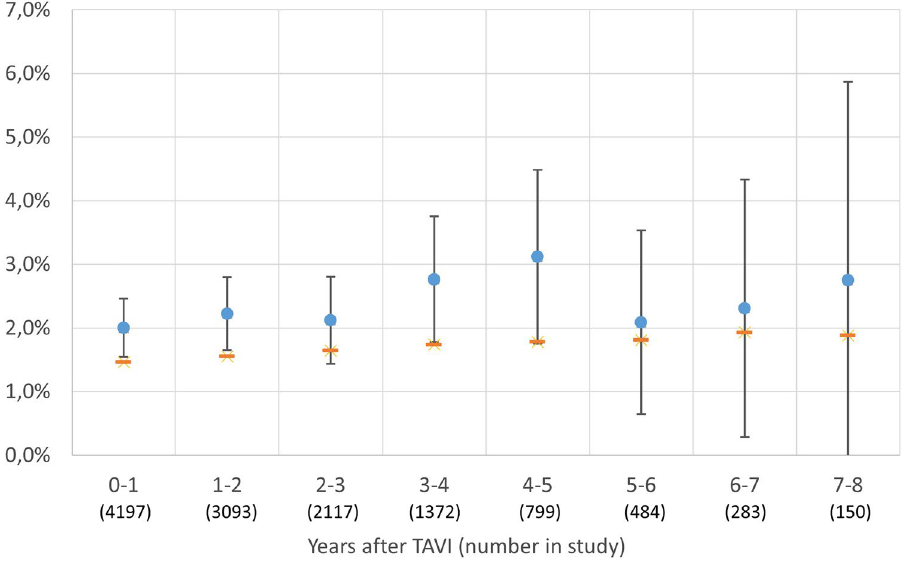
Figure 2. Risk for stroke per year post-TAVR with 95% CI. Red bar indicates standardized incidence calculated for this cohort of